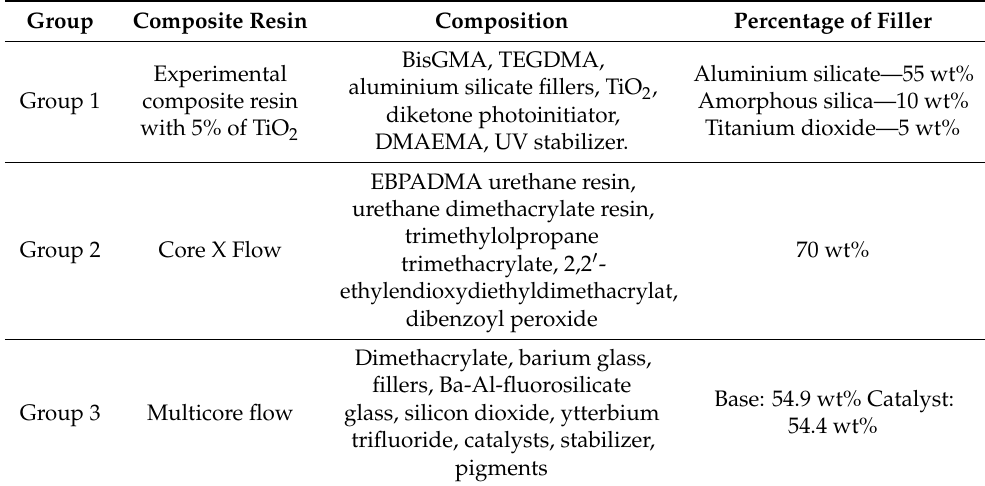
Table 1. Composition of composite resin used in this